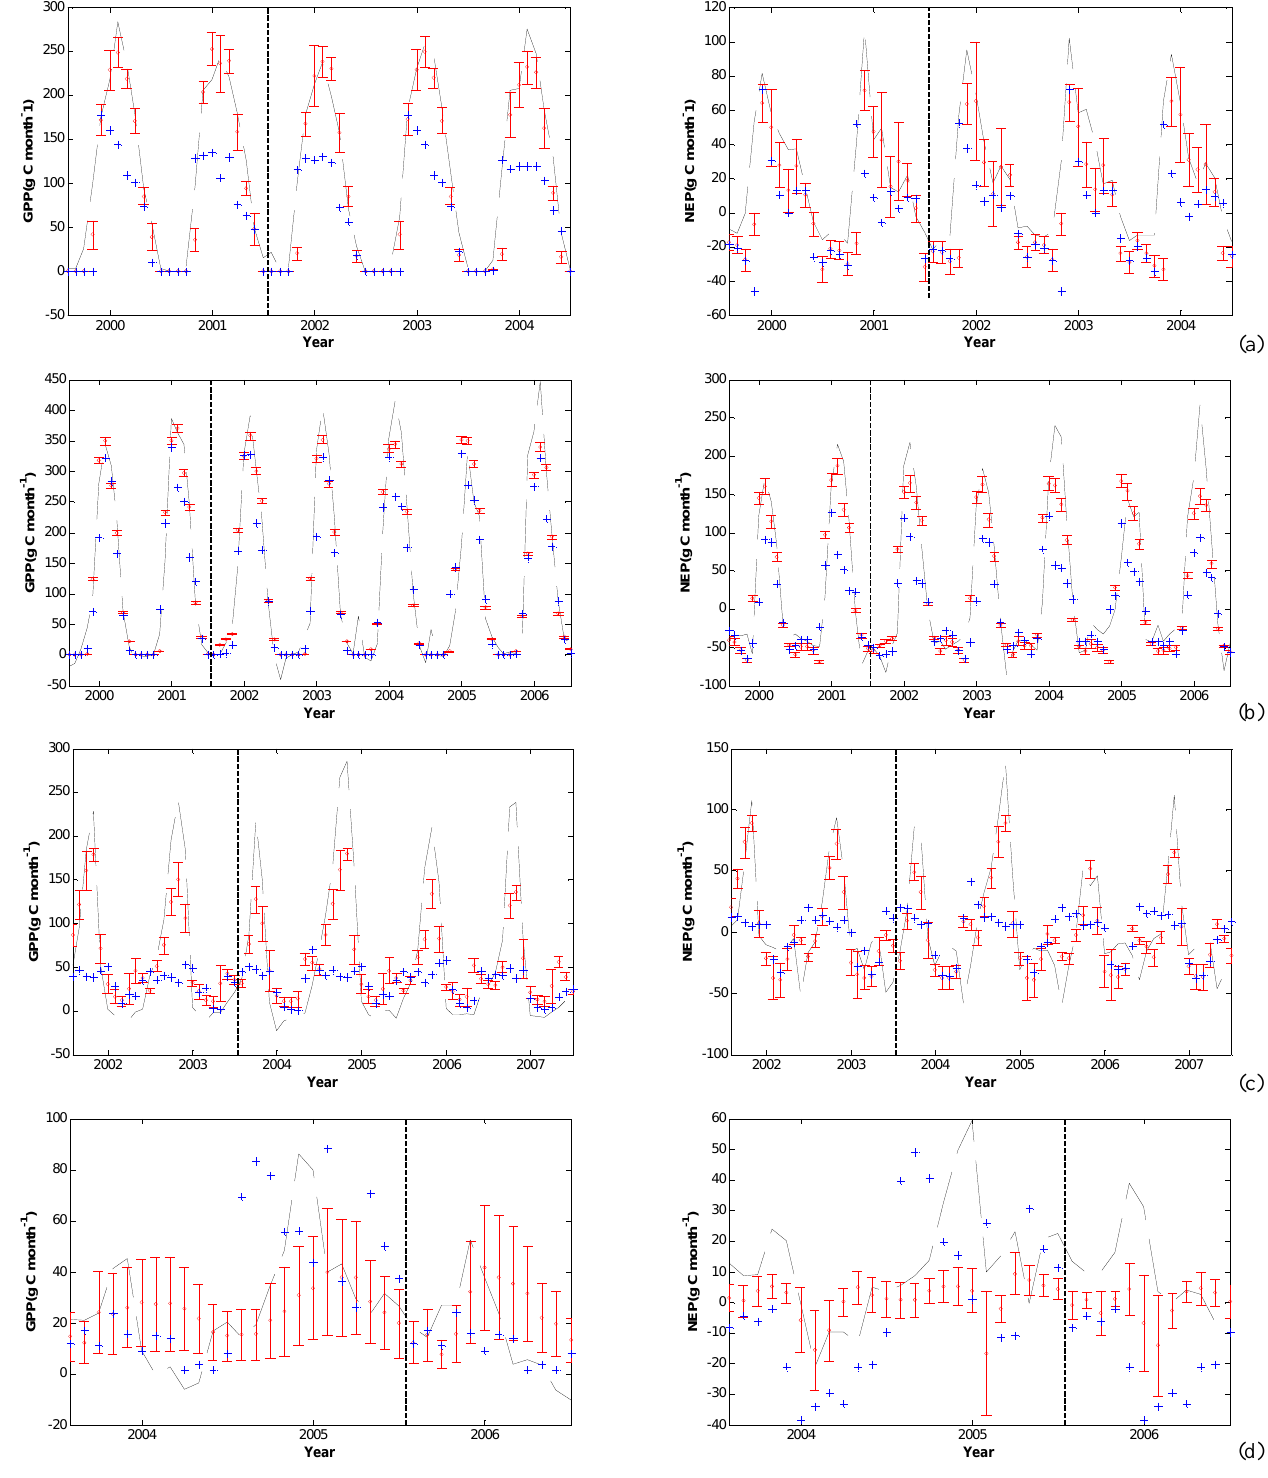
Fig. 2. Comparison of seasonal variations of the observed GPP and NEP with SAT-TEM and TEM predicted ones at the six parameterization sites. Dashed lines are the observations while circles and crosses are the predictions with SAT-TEM and TEM, respectively. The error bars indicates the standard deviation of the results by ensemble SAT-TEM simulations with 50 sets of posterior parameters. Data during the periods before the vertical dotted lines are used for parameterization while the remaining are verification results at: (a) Howland Forest West Tower site; (b) Harvard Forest site (c) Vaira Ranch site; (d) Sky Oaks New site; (e) Tonzi Ranch site; (f) Bondville